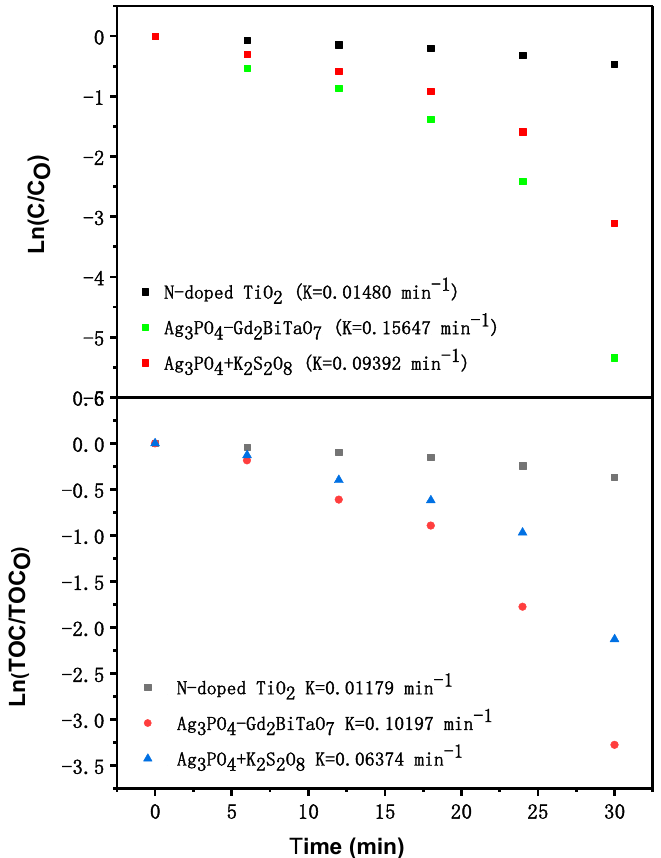
Figure 19. Observed first-order kinetic plots for the photocatalytic degradation of bisphenol A with Ag 3 PO 4 /Gd 2 BiTaO 7 heterojunction as photocatalyst, with N-doped TiO 2 as photocatalyst or with Ag 3 PO 4 and potassium persulfate as catalysts under visible light irradiation.